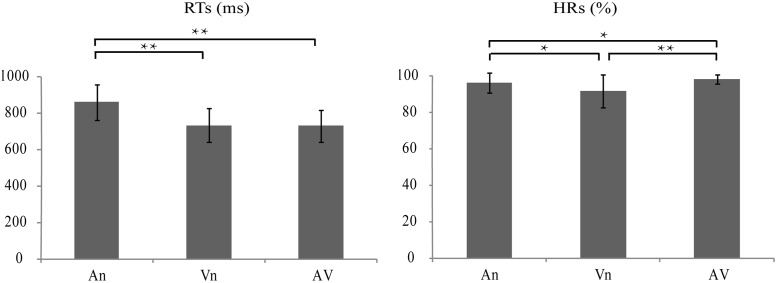
Bar plots showing response times (RTs) and hit rates (HRs) for the target under the three conditions (An, Vn, and AV stimuli).Left: RTs (across participants, mean ± SD). Right: HRs (across participants, mean ± SD). **Significant at p < 0.0005, *Significant at p < 0.05.